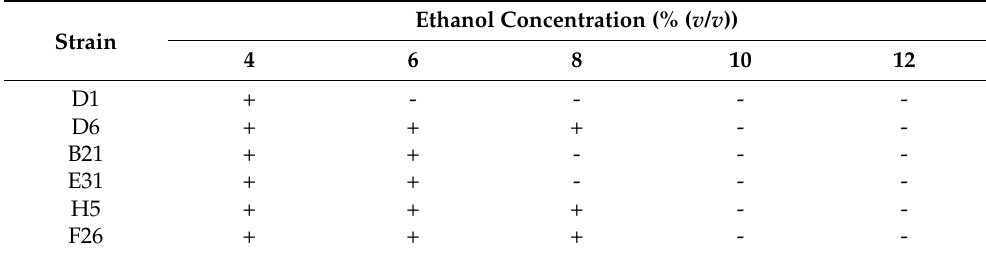
Table 1. The ethanol tolerance results of the screened strains. Ethanol Concentration (% ( v / v )) Strain 4 6 8 10 12 D1 + - - - - D6 + + + E31 H5 + + +